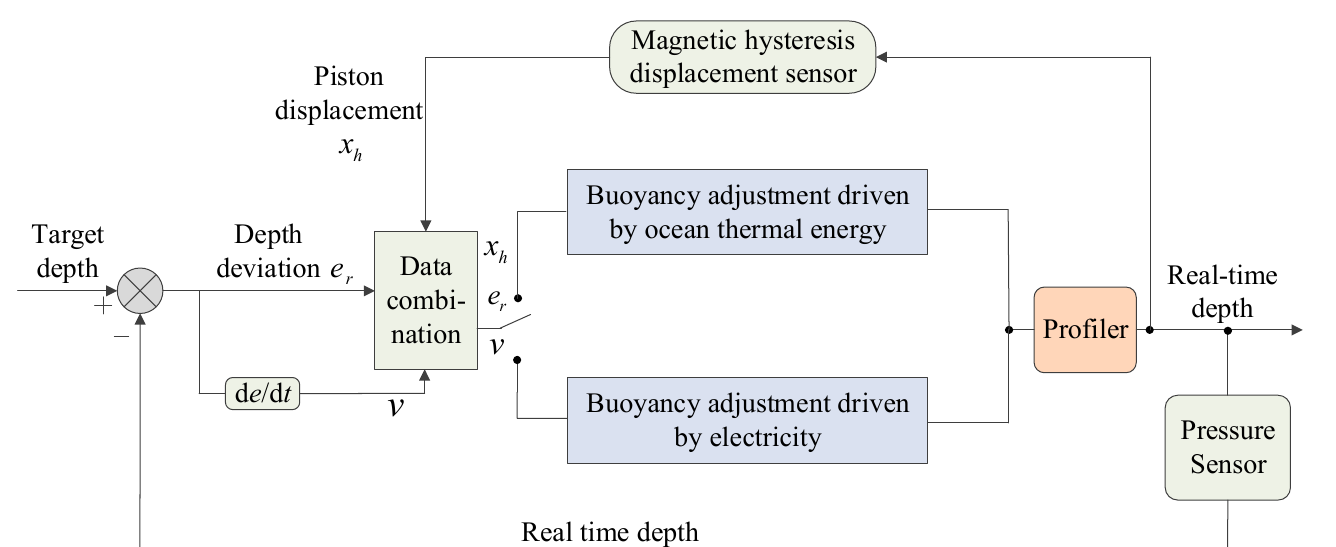
Figure 5. Schematic diagram of the profiler depth control strategy.